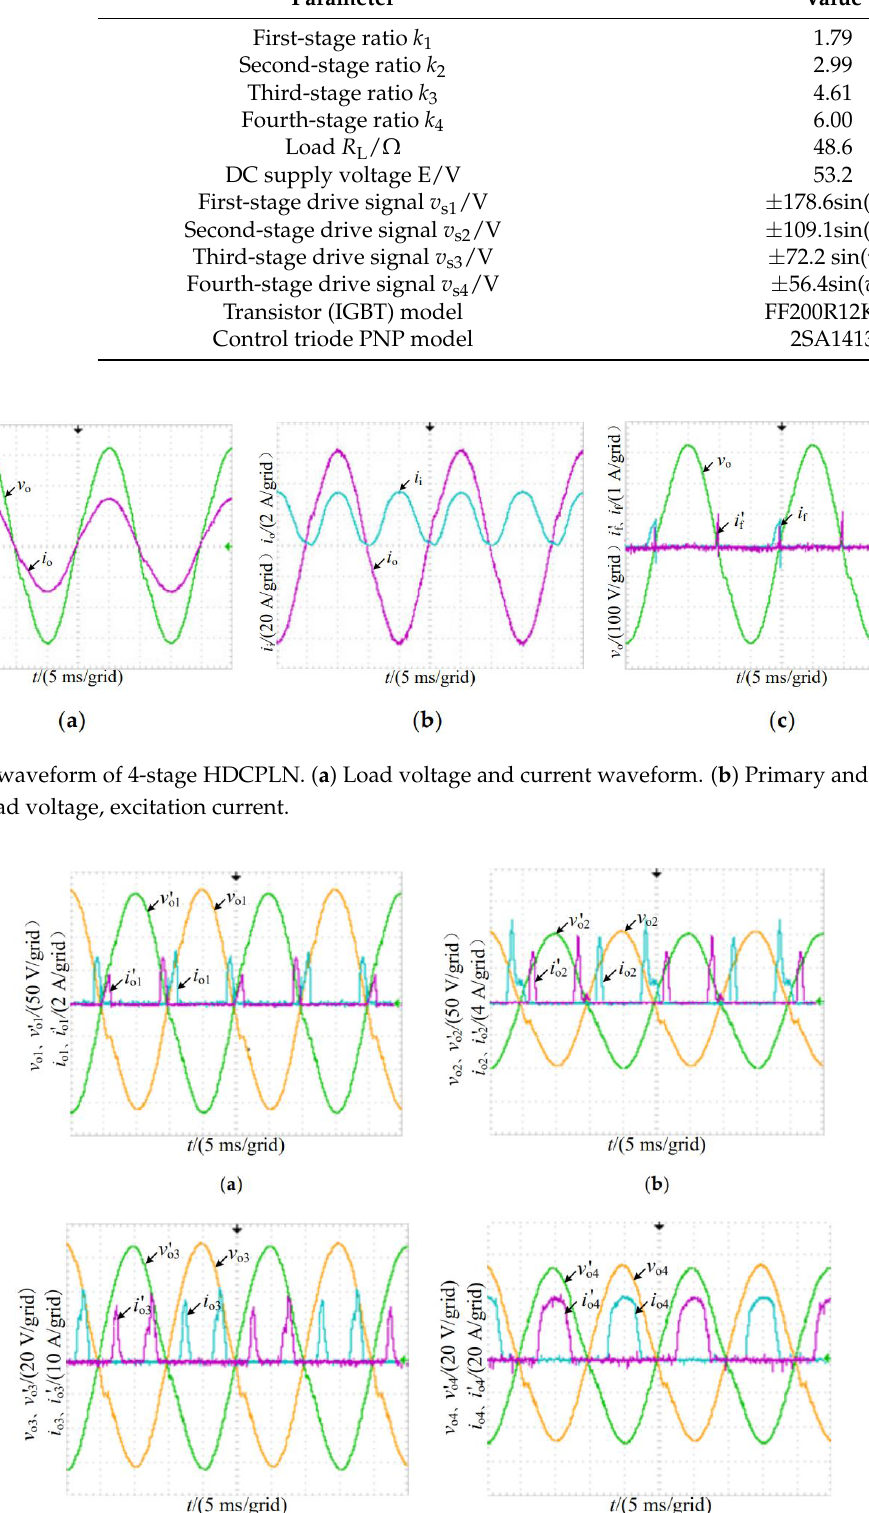
Figure 11. Current waveform of 4-stage HDCPLN. ( a ) Current on upper transistor at each stage. ( b ) Current on upper transistor at each stage. Figure 11 shows the current waveform of the transistor in each period of time in the HDCPLN. It can be seen that the power transistors (IGBTs) at various stages can switch the on and off states according to the control strategy, and the multistage converter circuit is linearly conducted in sections according to the timing. However, there is an overlapping part in the power-on period of each stage. When two IGBTs are turned on linearly, there are two-stage power converters working in parallel. This parallel operation can ensure